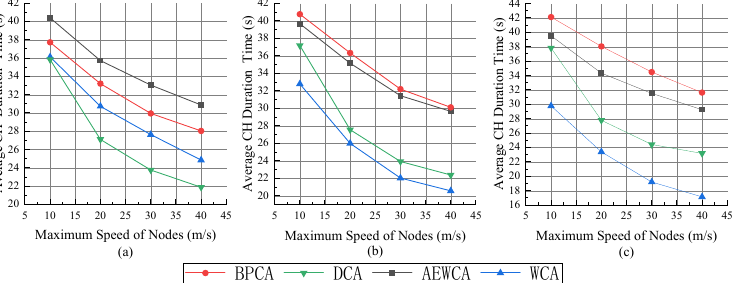
Figure 5. The effects of maximum movement speed on the average CH duration time. ( a ) Number of nodes is 100; ( b ) number of nodes is 150; ( c ) number of nodes is 200. (2) The average CM duration time The average CM duration time indicates the average time that a node is in the CM state during the simulation. The calculation of this metric is similar to the calculation of